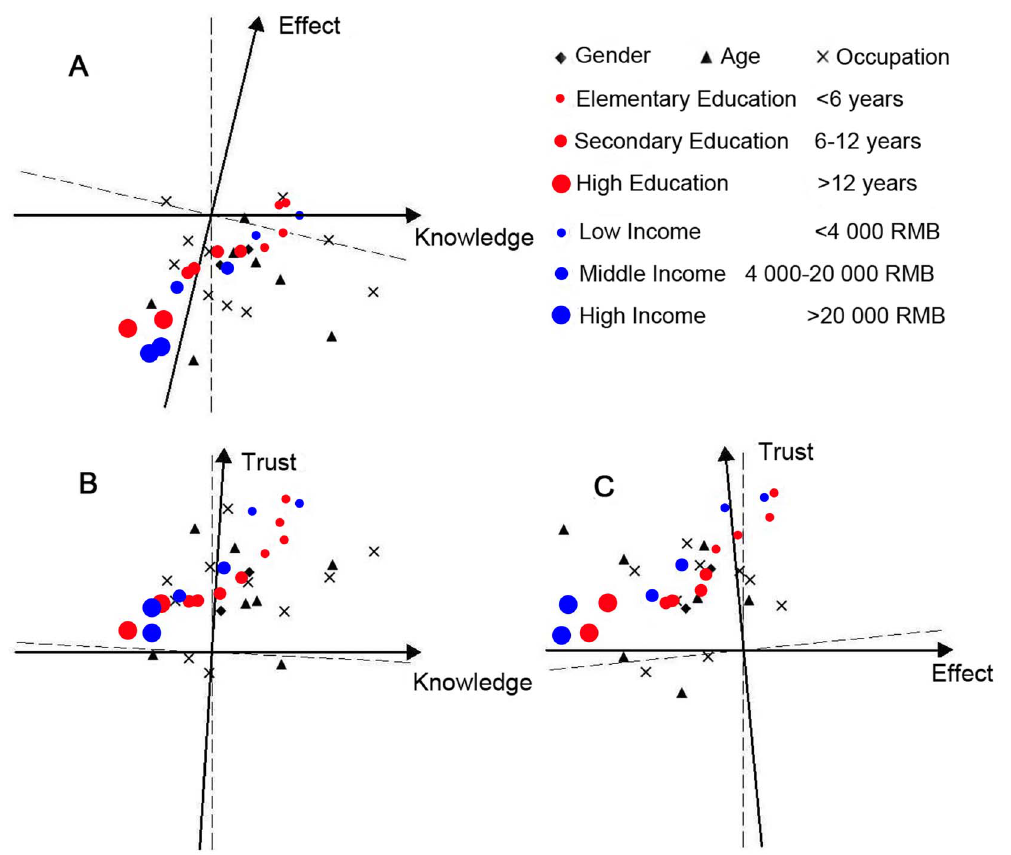
Figure 2. Individual risk perception factors for different demographic characteristics plotted in the factor space. doi:10.1371/journal.pone.0062486.g002 PLOS ONE |